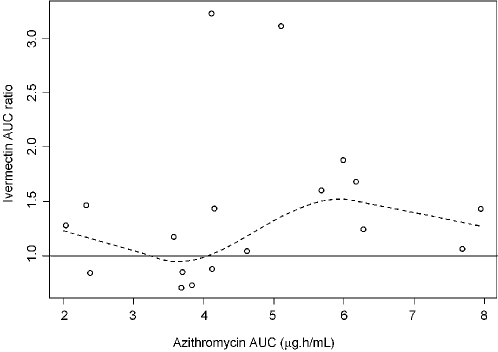
Ivermectin AUC ratio (AUC in interaction phase/AUC in baseline phase) versus azithromycin AUC in interaction phase.Solid line serves as a reference point of no change of ivermectin bioavailability; dotted line is Loess fit (local regression fit) to indicate lack of linear relationship. Circles are the observed individual values.